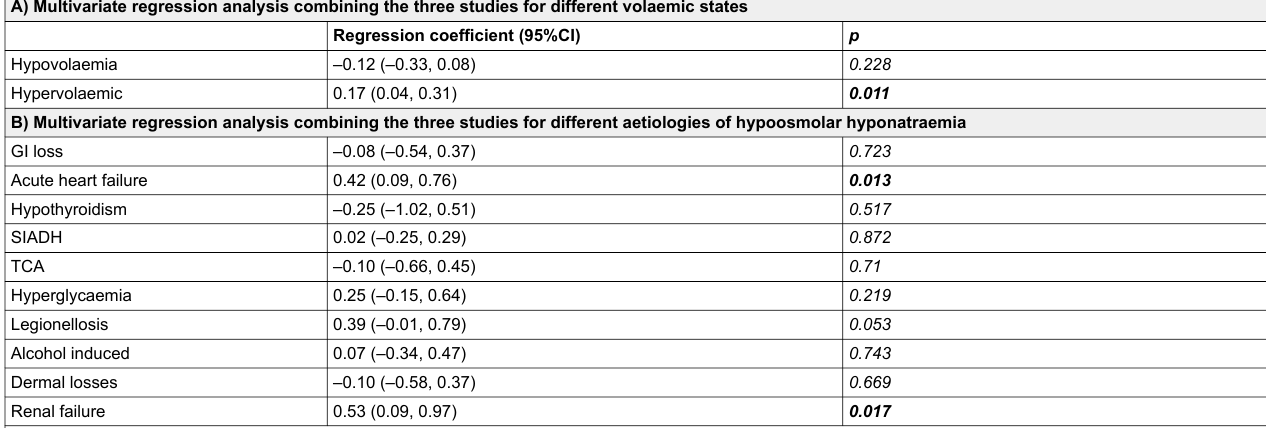
Results from multivariable hierarchical regression analysis adjusted for age and gender and including the different studies as a random effect. Regression coefficients represent units of increase in log transformed copeptin